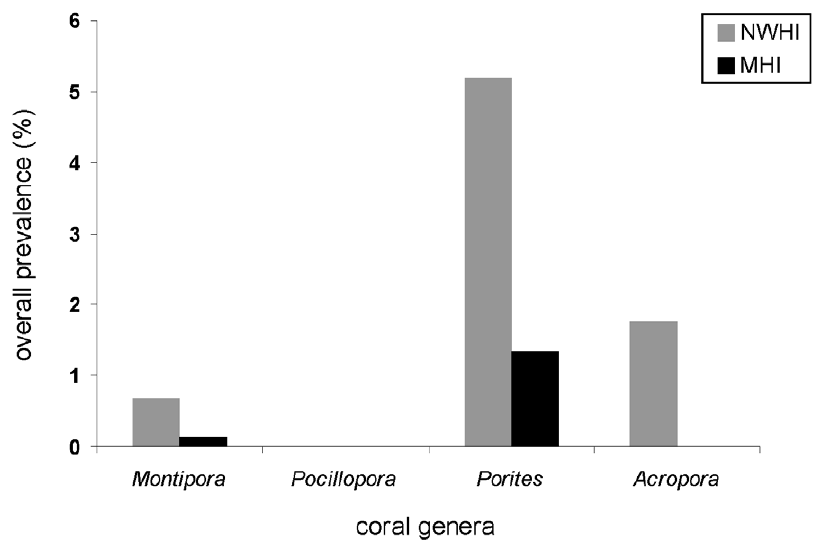
Figure 3. Differences among coral taxa in disease prevalence across the Hawaiian archipelago.